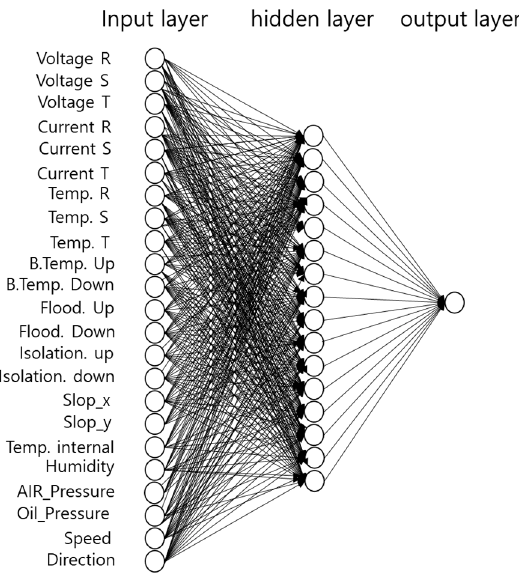
Figure 7. ESP’s failure predictive diagnostic neural